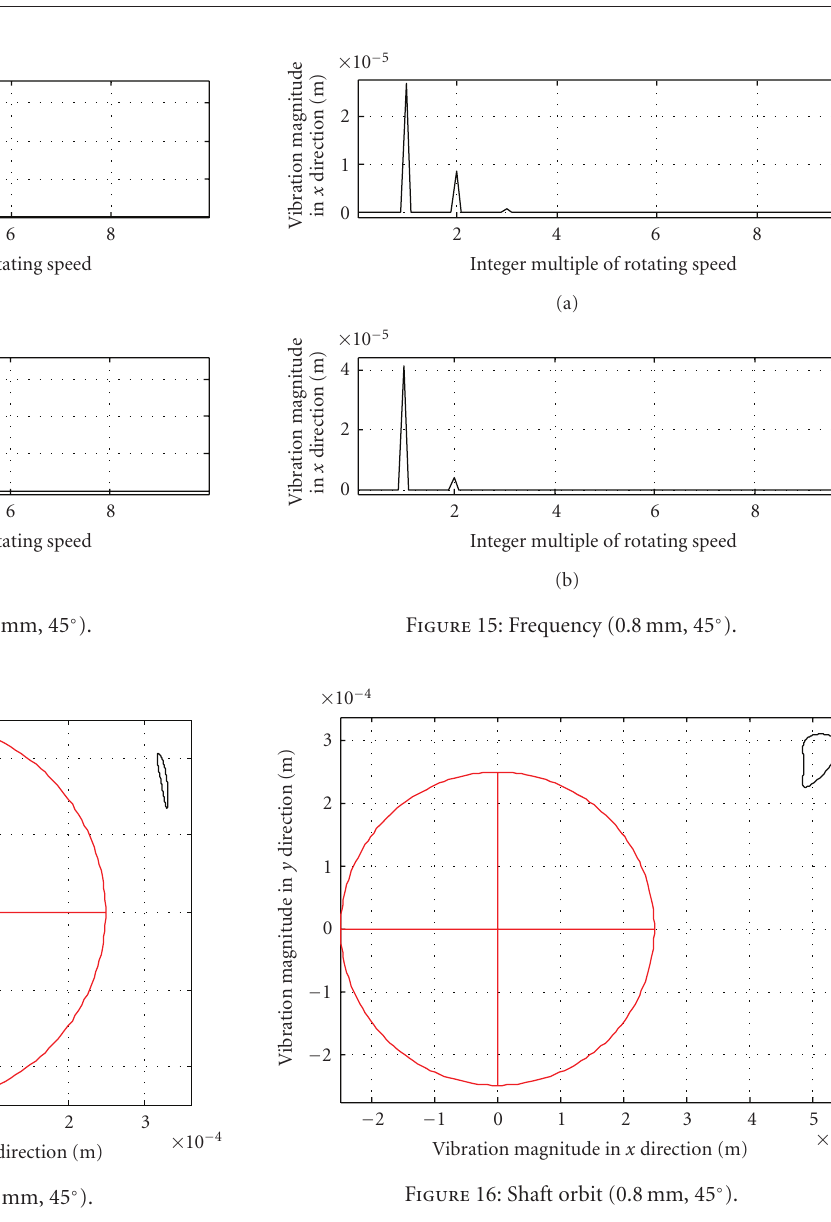
Figure 14: Shaft orbit (0.4 mm, 45 ◦ ).